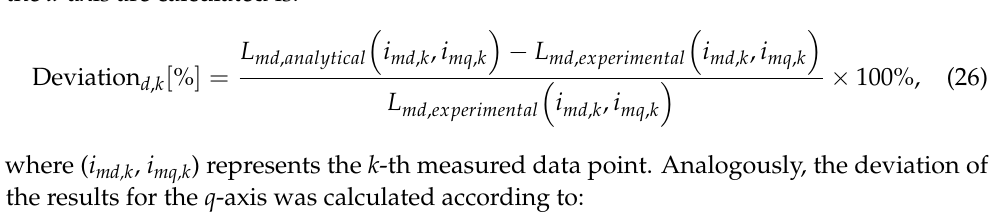
Figure 11. Comparison between the obtained experimental and analytical results with corresponding deviations for the q -axis magnetizing inductance: ( a , d ) Method 1 (Levi); ( b , e ) Method 2 (Kaukonen); ( c , f ) Method 3 (El-Serafi & Wu).